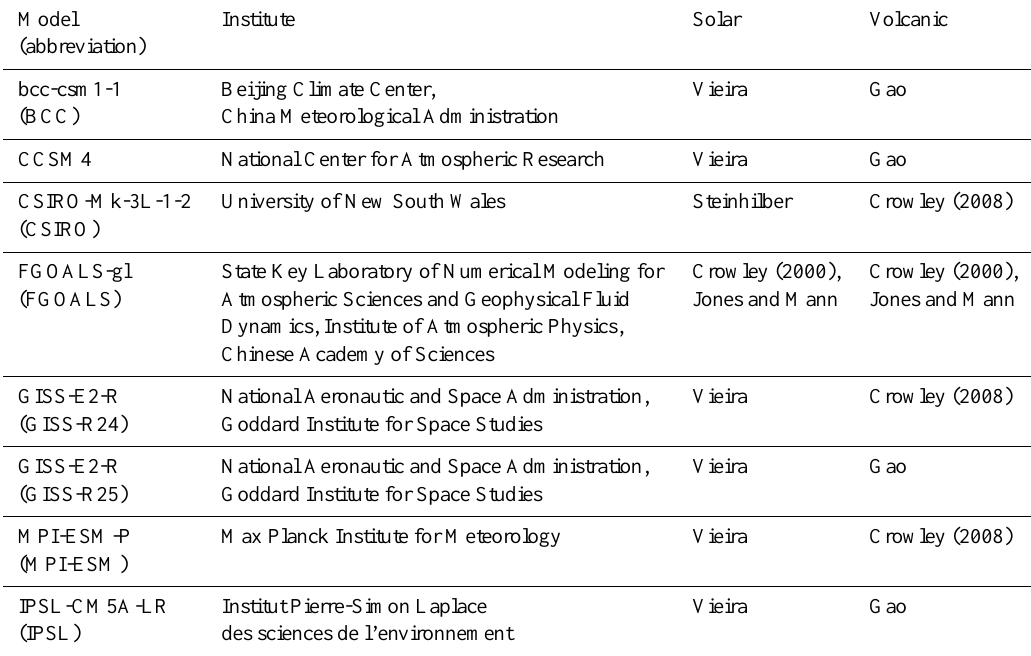
Table 1. Selected climate model simulations and their abbreviations, the institutes of origin and the respective solar and volcanic forcing data sets. Full references are (from top to bottom) Vieira et al. (2011), Gao et al. (2008), Steinhilber et al. (2009), Crowley (2000), Jones and Mann (2004) and Crowley et al.